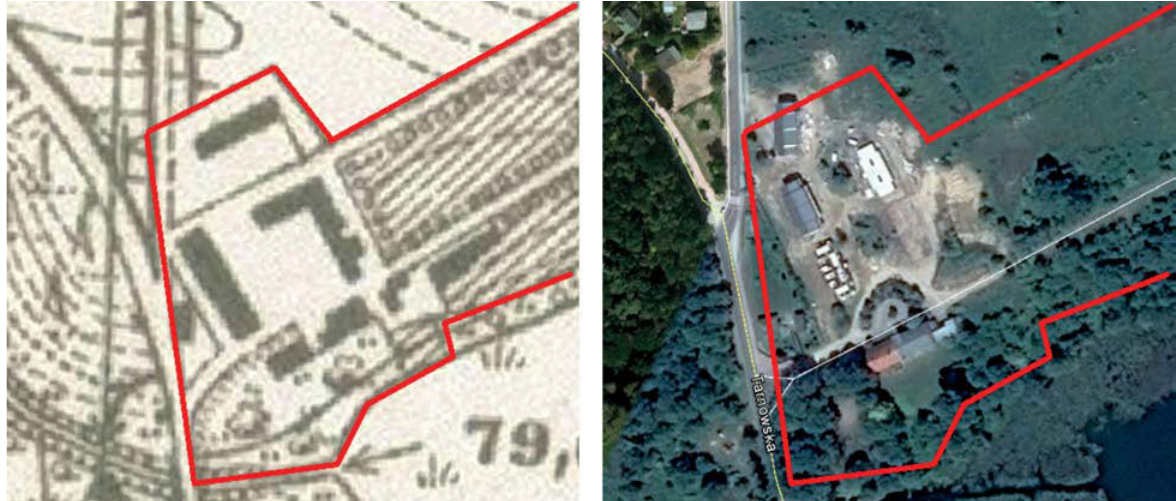
Fig. 8. Legible spatial arrangement of the manorial and grange complex in Lusówko on a map issued in the 1940s and on a contemporary orthophoto map, marked with a red line.